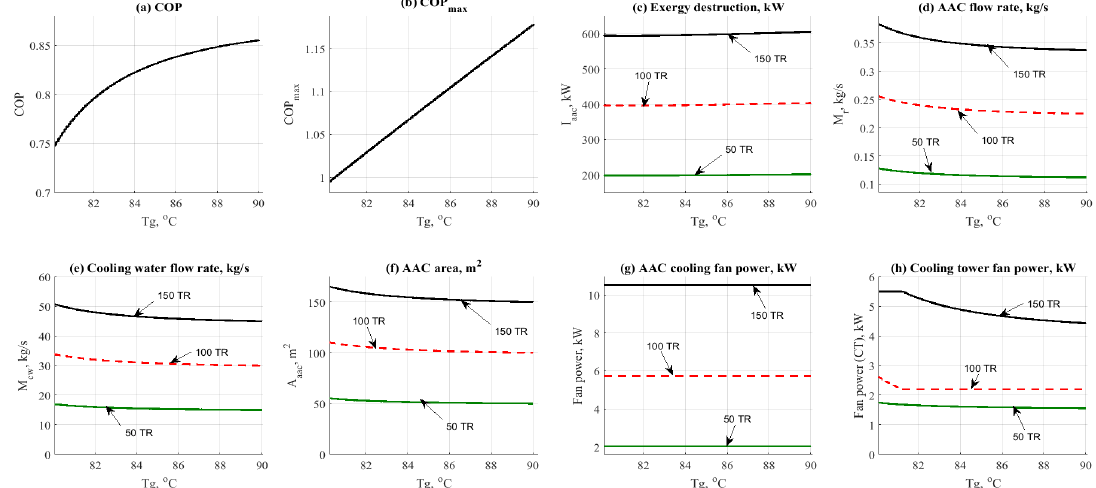
ff ect of generator temperature Figure 6. Data results based on the effect of generator temperature parameter. Figure 6. Data results based on the e